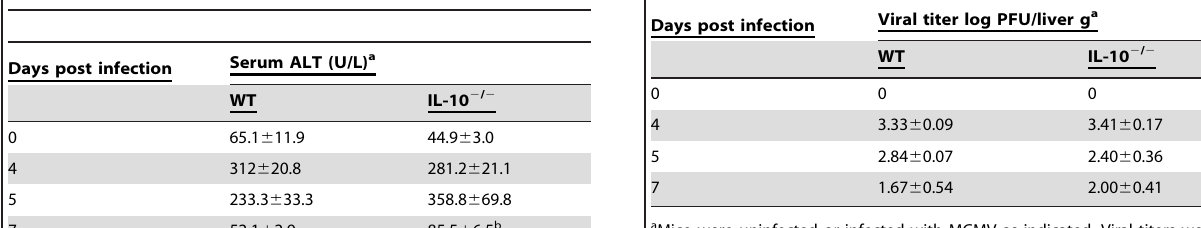
Table 2. Serum alanine aminotransferase (ALT) levels of uninfected and MCMV infected C57BL/6 (WT) and IL-10 2 / 2 mice.